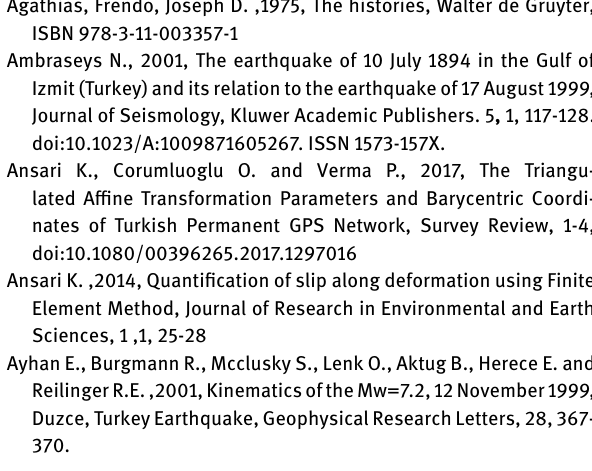
ments in the western region is due to the incremen- tal seismicity which generates a ring in the southern Aegean Sea around the relative seismic